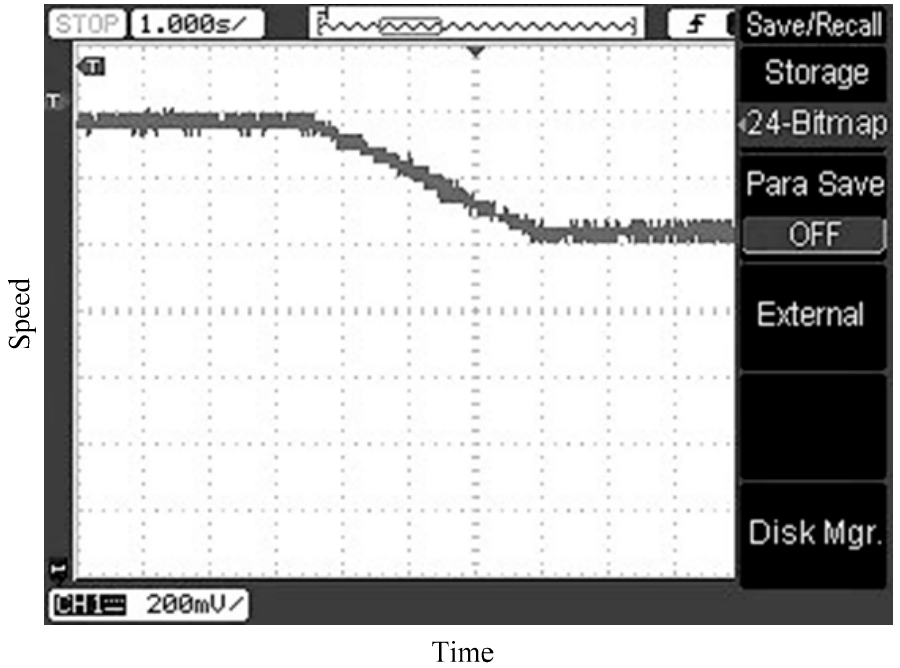
Figure 17. The transient performance of Iq S of the entire drive system under variable speed from 0.4 pu to 0.2 pu.